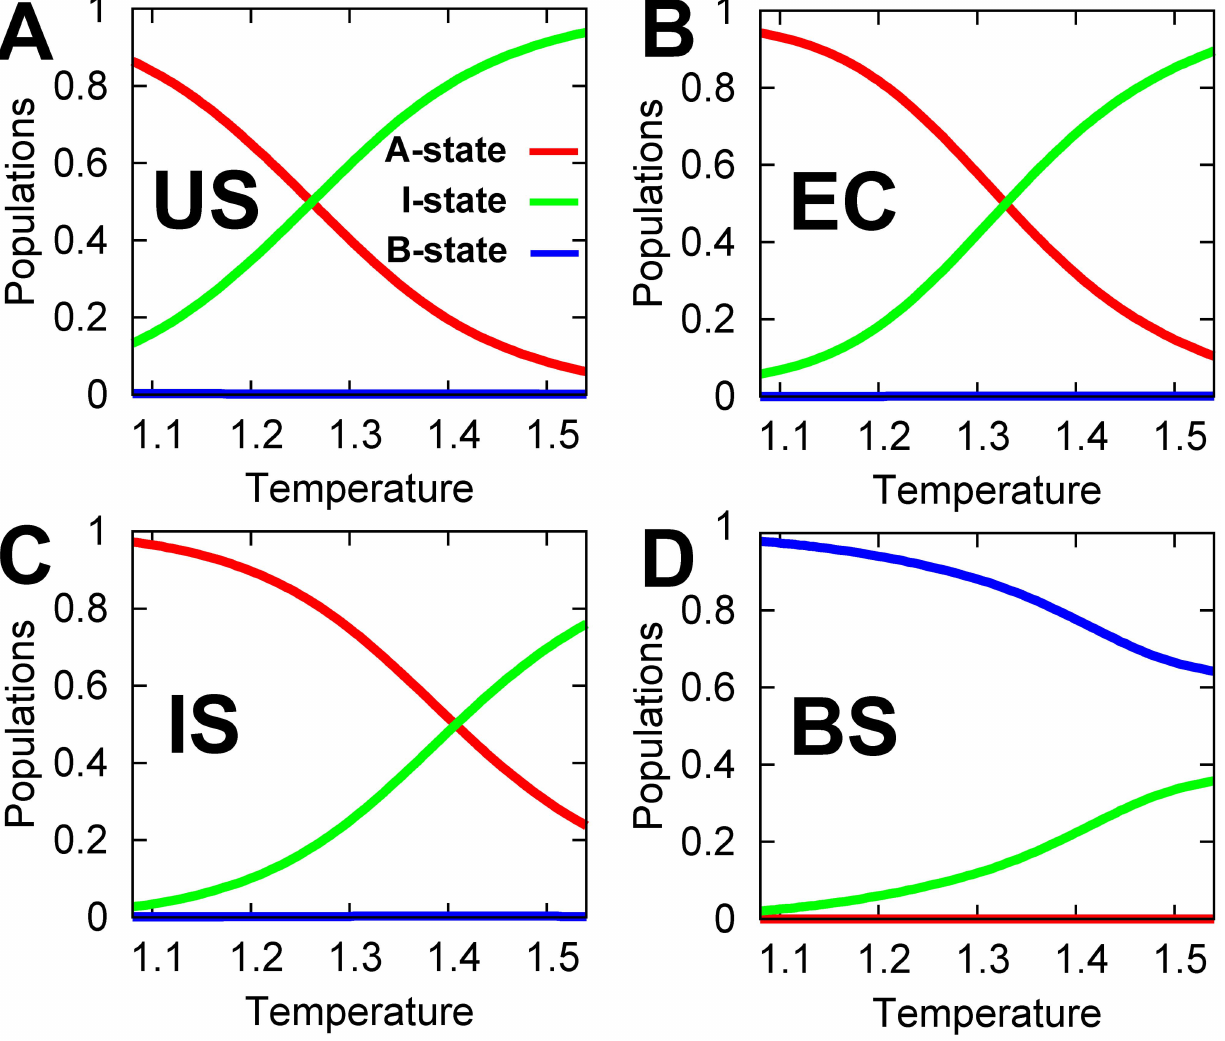
Figure 2. Conformational dynamics of DPO4 change with temperature. The population distributions of the A- (red lines), I- (green lines) and B-state (blue lines) in the (A) US, (B) EC, (C) IS and (D) BS are shown as a function of temperature. Temperature is energy unit ( E LJ ).